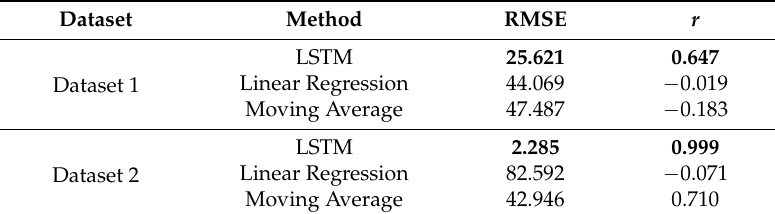
Table 4. The model comparison for forecasting